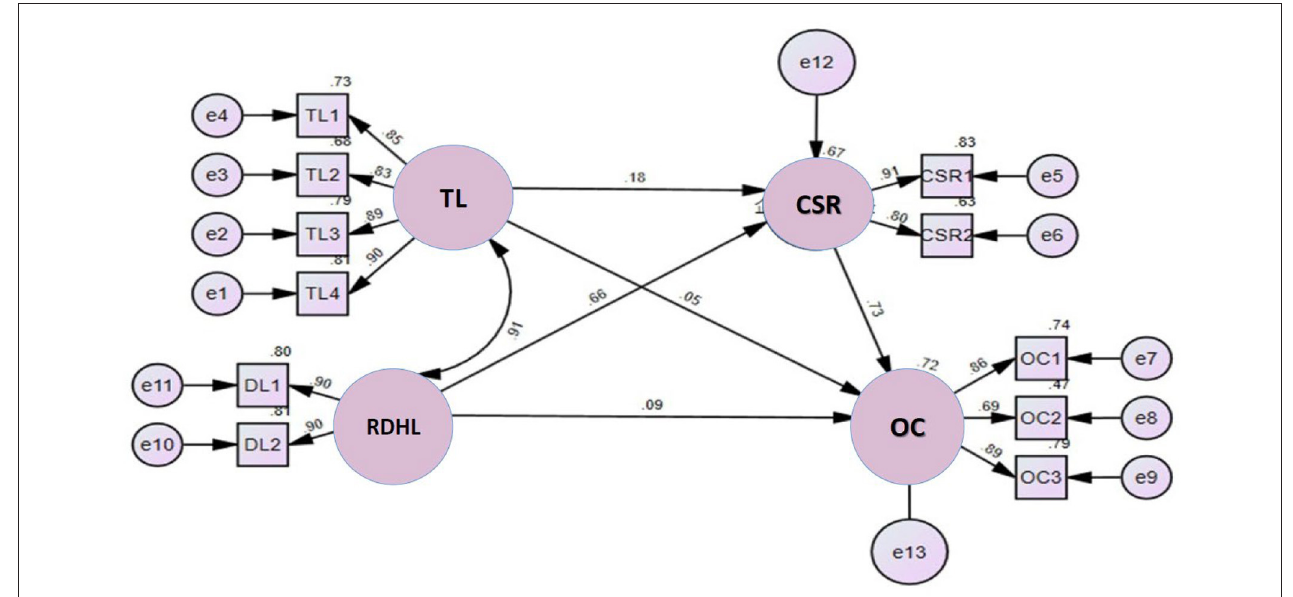
FIGURE 2 | Path diagram of the SEM model.